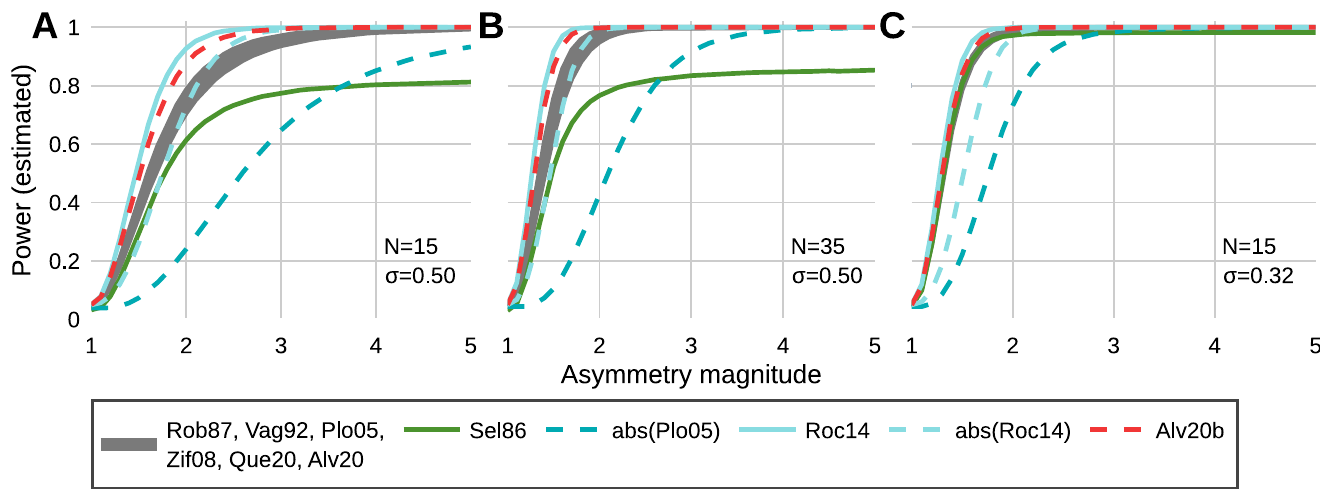
Fig 1. Estimated power vs. asymmetry magnitude. Estimated power for (A) a sample size of 15 and a variability of 0.50. (B) a sample size of 35 and a variability of 0.50. (C) a sample size of 15 and a variability of 0.32.